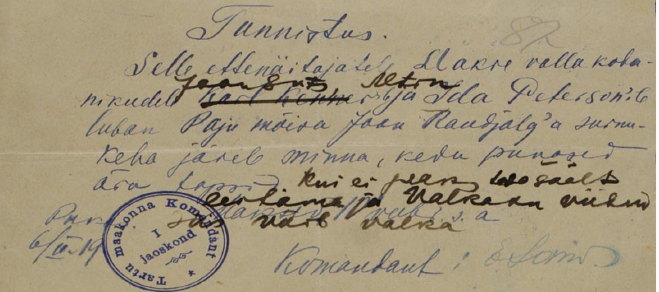
Figure 5. The document from the National Archives of Estonia pointing to the names Jaan Luts, N.N. Altin and Ida Peterson